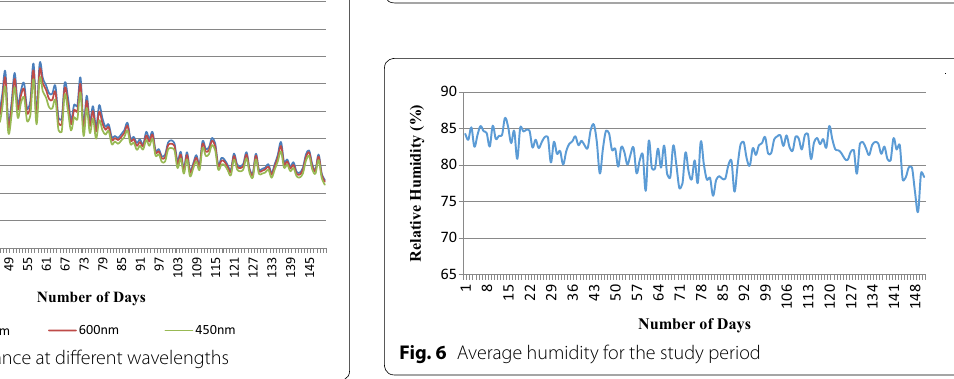
Fig. 5 Temperature variation during study period